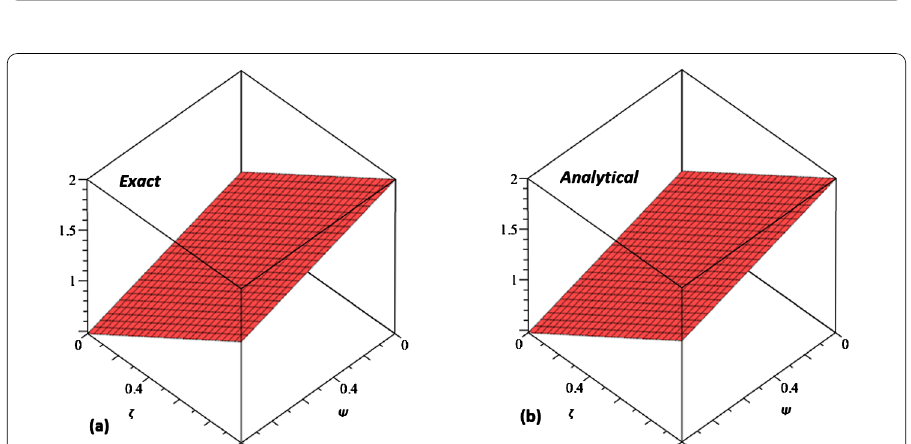
Figure 7 The μ -solution graph of example 3, ( a ) exact solution and ( b ) ETDM solution at δ = 1